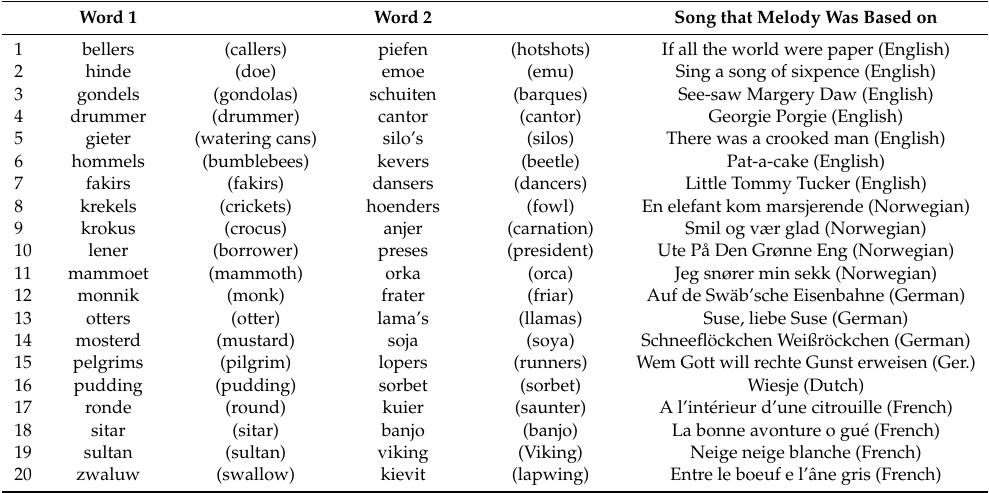
Table 2. The 20 target word pairs (English translation in parentheses), and songs that were the base for the melody of that specific word pair (language of lyrics of original song in